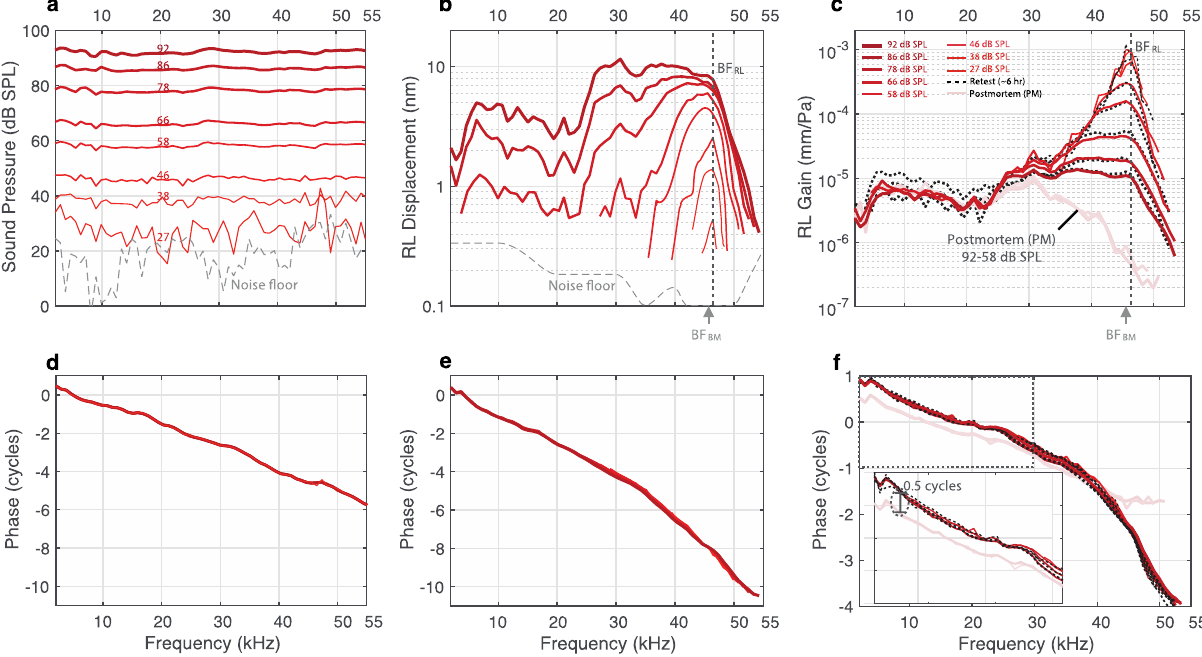
Figure 2. In vivo RL 3 vibrometry measurements at different stimulus levels in the hook region of the gerbil cochlea (G637). ( a ) The ear-canal sound pressure levels of pure tones used to stimulate the specimen, ranging from an average of 27 to 92 dB SPL (line thickness and darkness increase with level), as well as a noise-floor reading (gray dashed line). ( b ) RL 3 displacements as functions of frequency, corresponding to the different stimulus levels in panel ( a ). Displacement measurements were rejected at frequencies where their magnitude was less than 6 dB above the noise floor (gray dashed line). The best frequency (BF) for the RL 3 location (BF RL ) was 46.4 kHz (gray dotted vertical line), and for the BM APJ location (BF BM ) was 45.6 kHz (gray arrow below the panel). ( c ) The in vivo (dark red) and postmortem (PM; faded red) RL 3 displacements were normalized by the stimulus sound pressure to produce the RL Gain (in units of mm/Pa). The black dotted lines indicate repeated in vivo measurements made ~ 6 h later. ( d – f ) The respective phase responses of the sound pressure, RL 3 displacement, and RL 3 gain. ( f ) An enlarged view of the RL 3 -gain phase from the black-dotted region of the panel is